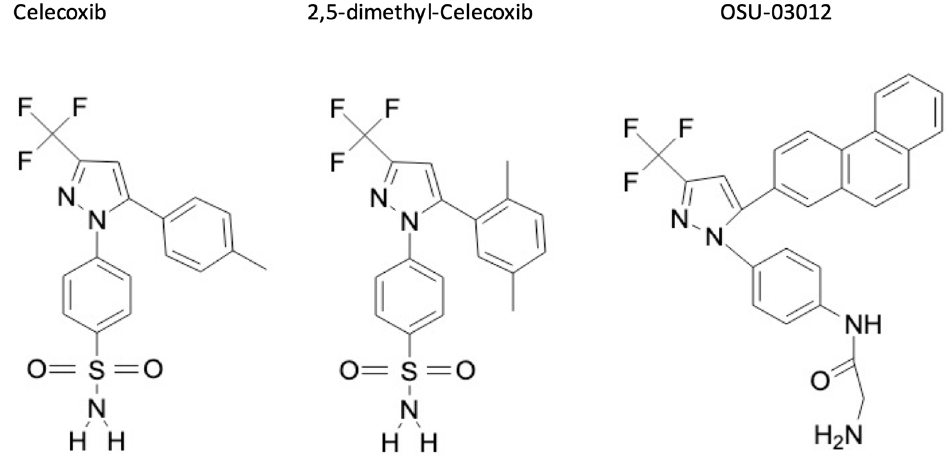
Figure 1. Chemical structures of celecoxib, 2,5-Dimethyl-celecoxib and OSU-03012. Chemical struc- tures were retrieved from https://pubchem.ncbi.nlm.nih.gov (accessed on 29 April 2021) and re- drawn using Chemdrawdirect (https://chemdrawdirect.perkinelmer.cloud/js/sample/index.html# accessed on 29 April 2021).